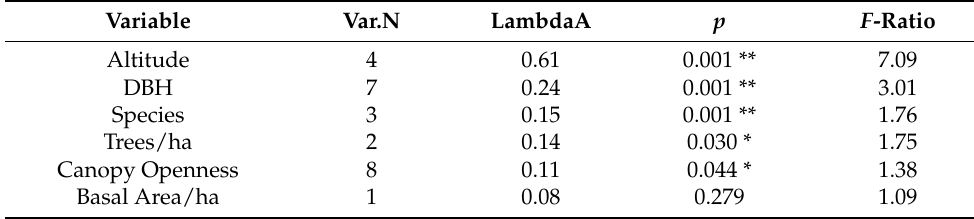
Table 2. CCA model p-values for each variable